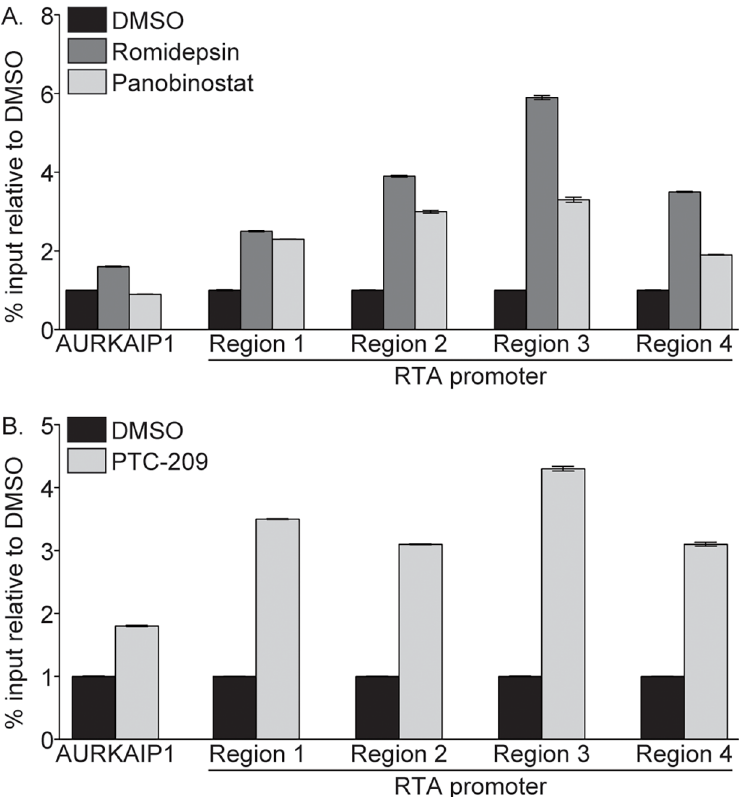
Fig 6. Romidepsin, Panobinostat, and PTC-209 induce nucleosome depletion at the RTA promoter. Nucleosome density was assayed by FAIRE-qPCR in 293-KSHV.219 cells treated with DMSO or 1 μ M Romidepsin or Panobinostat (A), or DMSO or 10 μ M PTC-209 (B). Data are representative of at least three independent